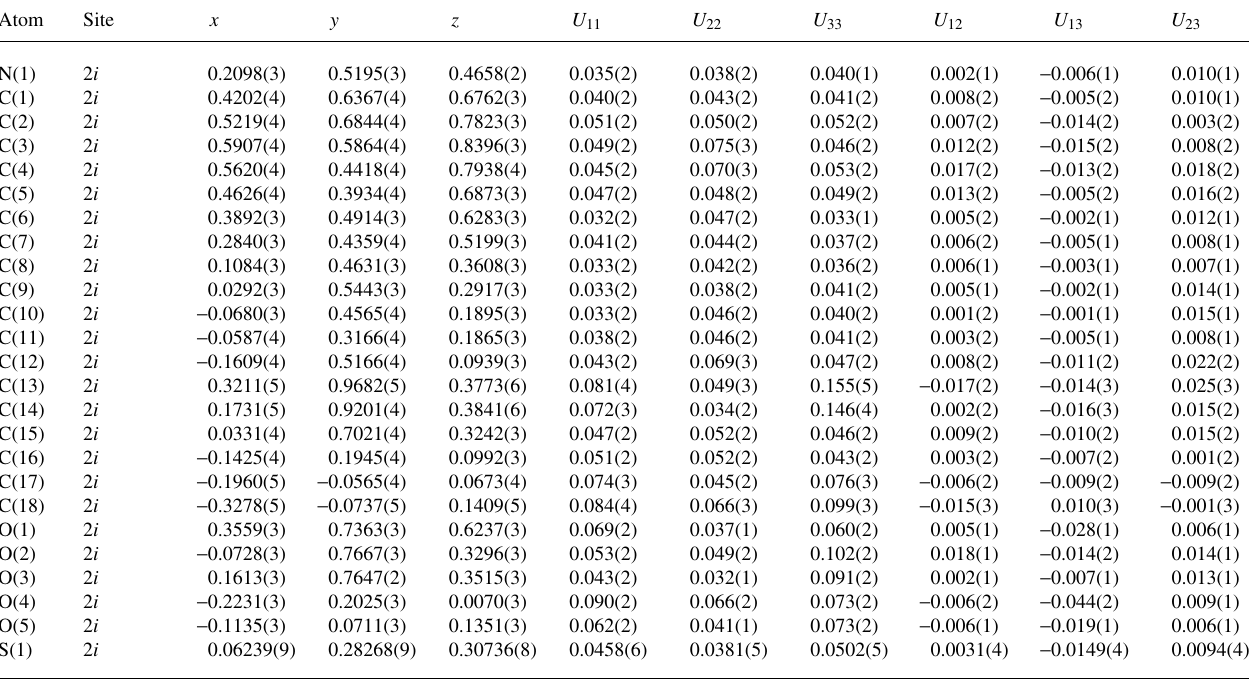
Table 3. Atomic coordinates and displacement parameters (in Å 2 )